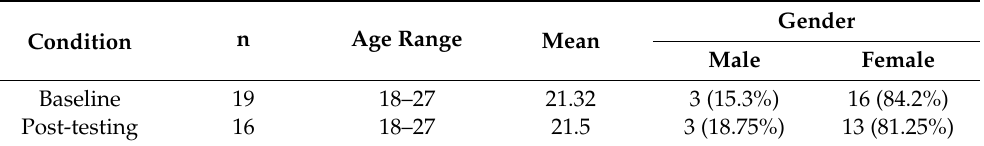
Table 1. Demographic data (age and gender) of the patients divided into the baseline and post-testing conditions.